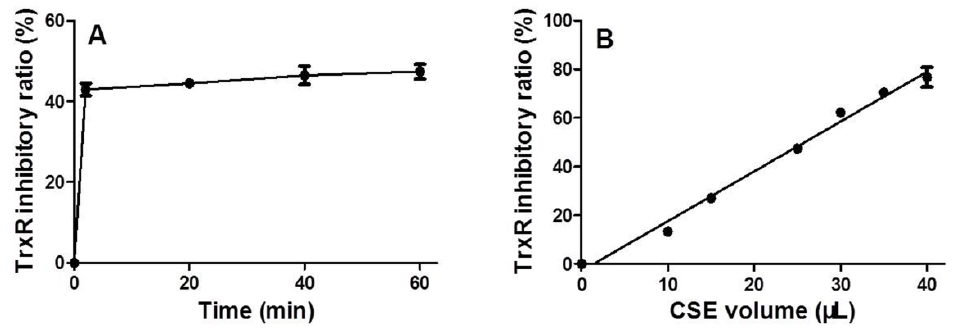
Figure 3. Time ( A ) and dose ( B ) effects of cigarette smoke extract (CSE) on thioredoxin reductase (TrxR) activity. Data are presented as means ± SEM ( n = 2).